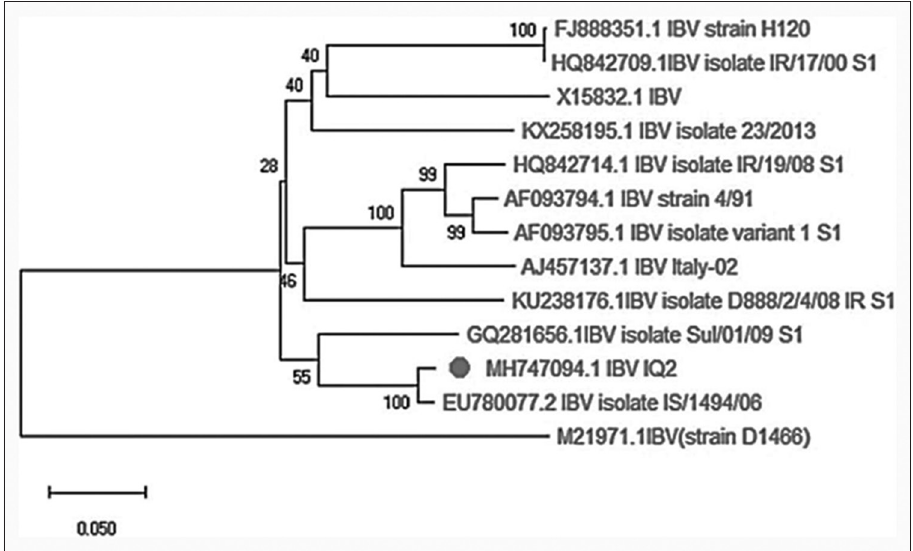
Figure-1: Phylogenetic tree of the infectious bronchitis virus based on the infectious bronchitis virus-IQ2 S1-spike gene partial sequencing with a comparison to world sequence Table-1: Avian coronavirus (aCoV incl IBV) and IB variant detection using species-specific and variant-specific RT-PCR.